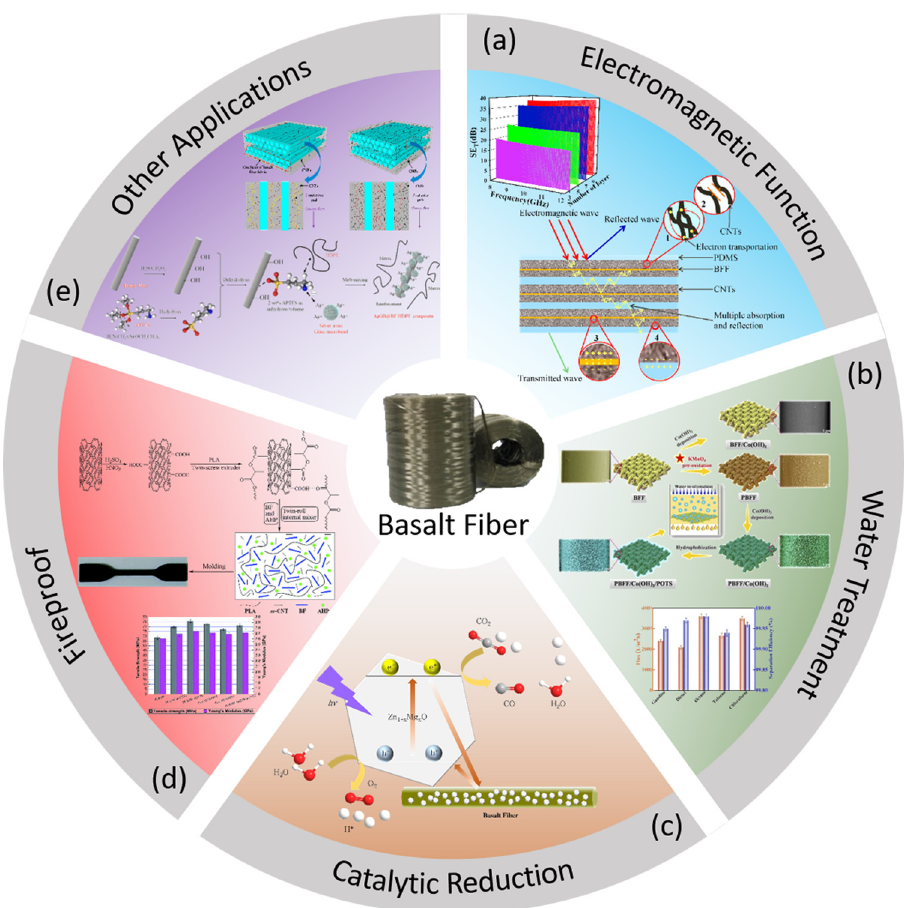
Figure 1: Schematic diagram showing the di ff erent applications of basalt fi ber - based functionalized composites [ 32 ] : ( a ) electromagnetic function [ 33 ] , ( b ) water treatment [ 26 ] , ( c ) catalytic reduction [ 34 ] , ( d ) fi reproof [ 35 ] and ( e ) other applications [ 31,36 ]